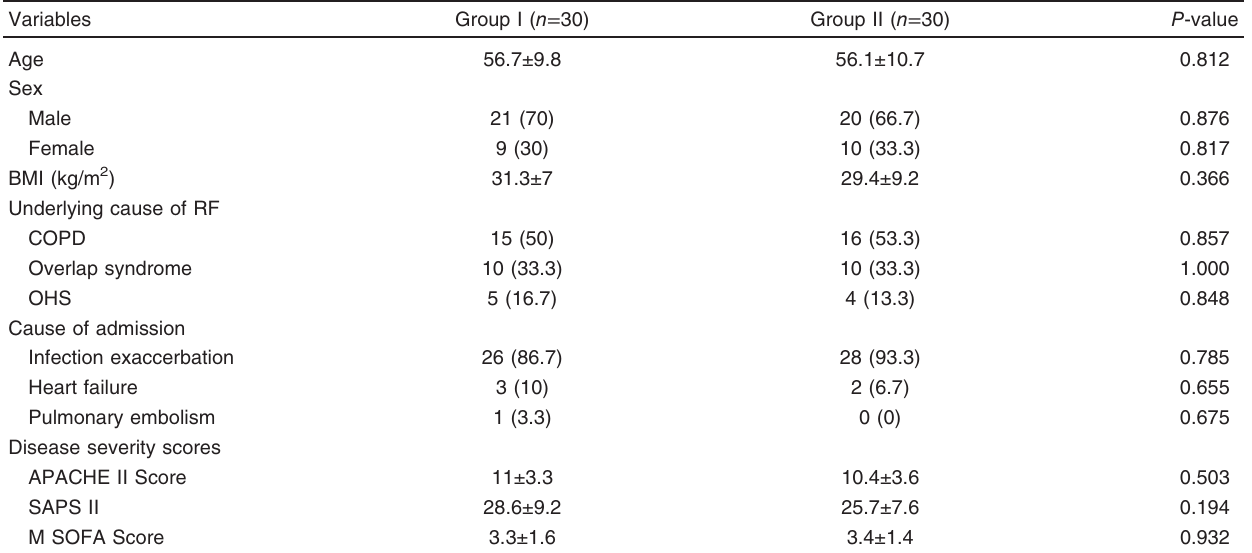
Table 1 Demographic data of the study group ( n = 60) Variables